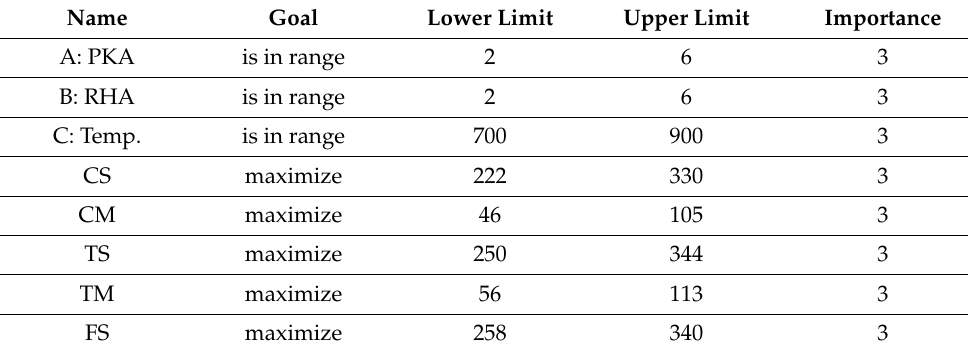
Table 10. Optimization